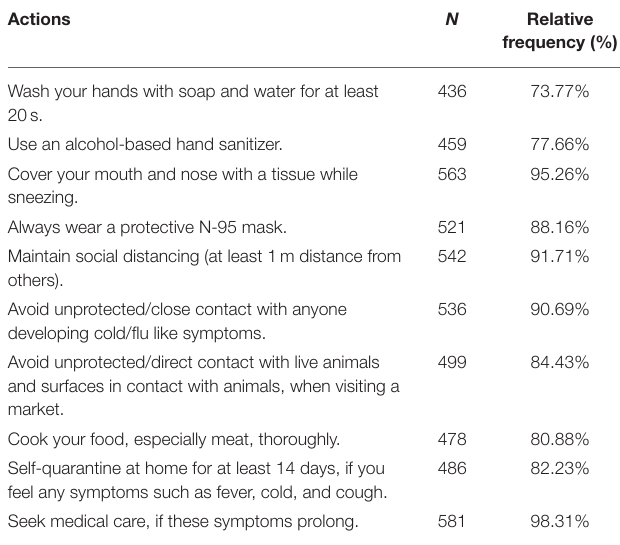
TABLE 2 | Relating frequencies (%) related to various myths. Myths